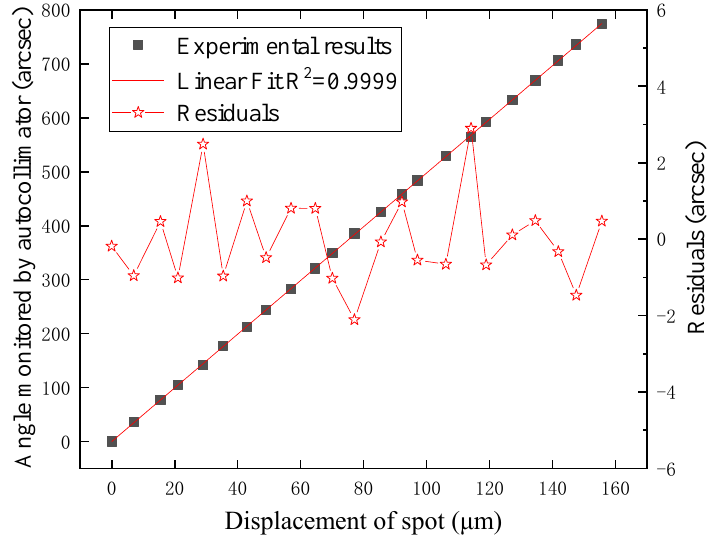
Figure 9. Calibration results in the Y direction.